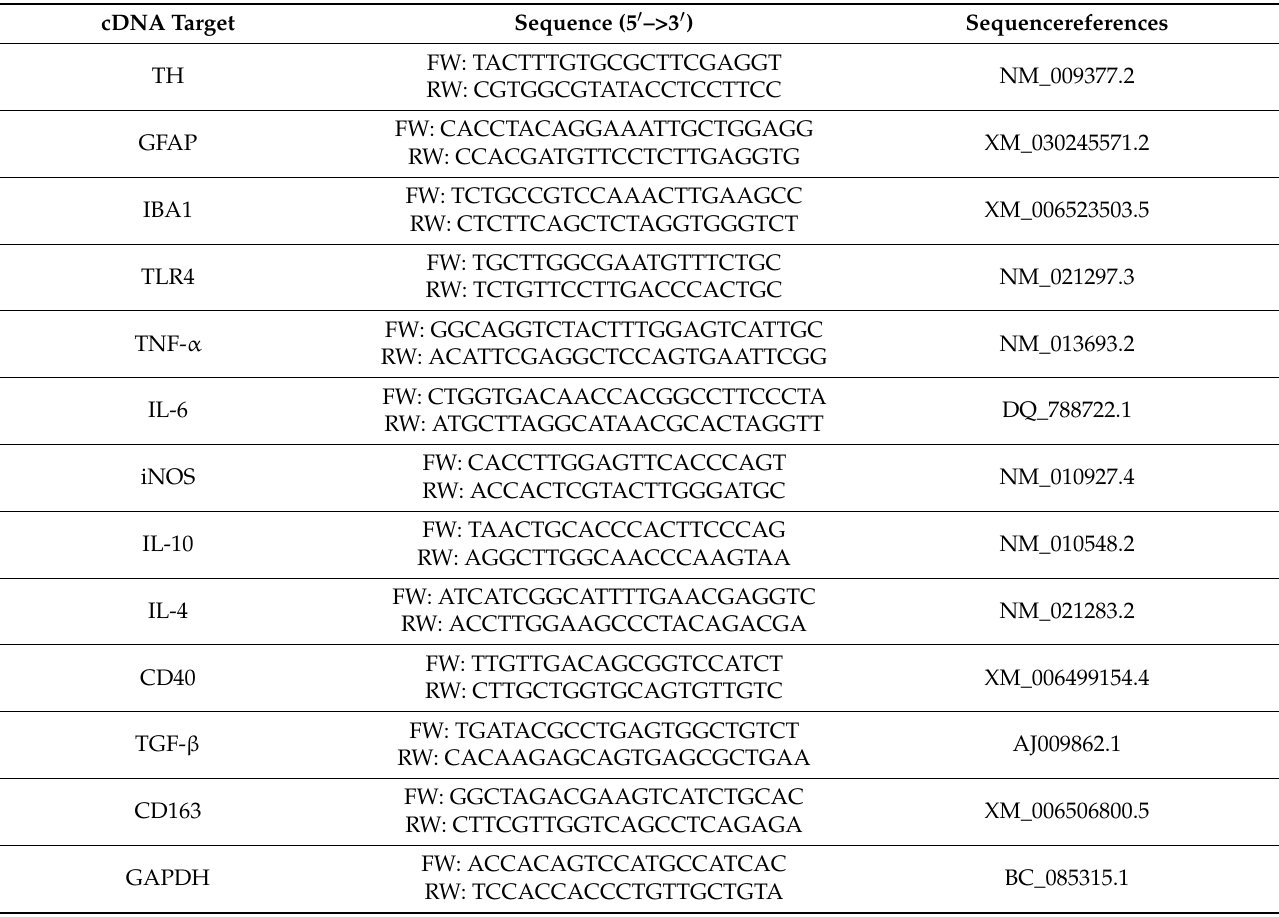
Table 1. List of primers sequences usedfor PCR